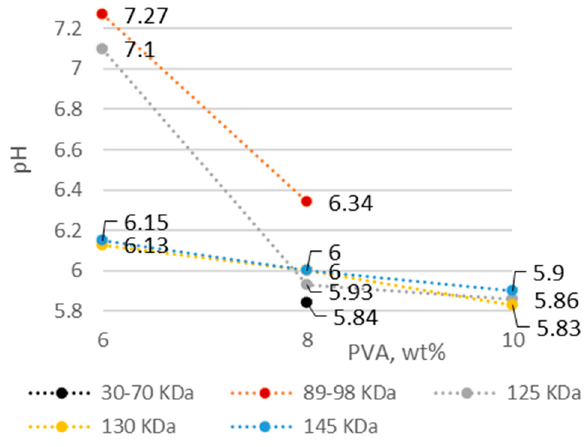
Figure 4. The pH values of electrospinning solutions depending on the concentration and molecular weight of polyvinyl alcohol.